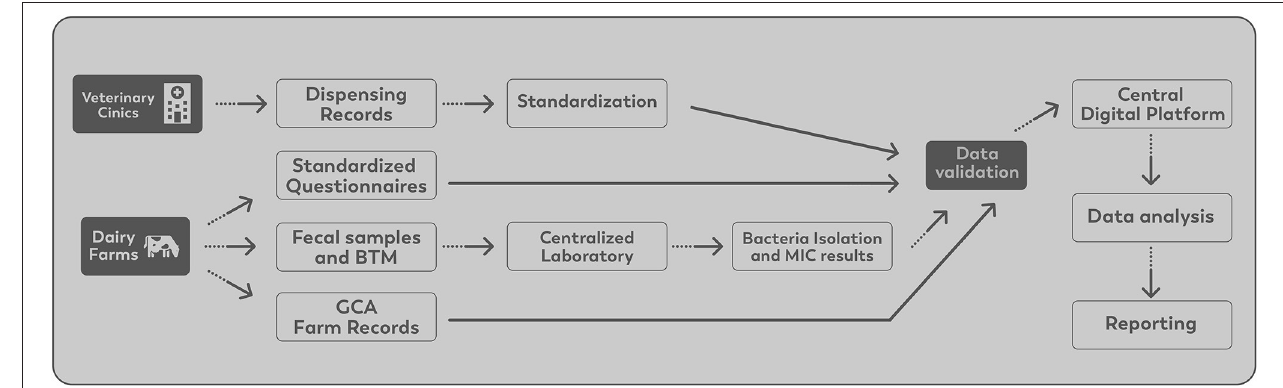
FIGURE 3 | CaDNetASR communication policy and data